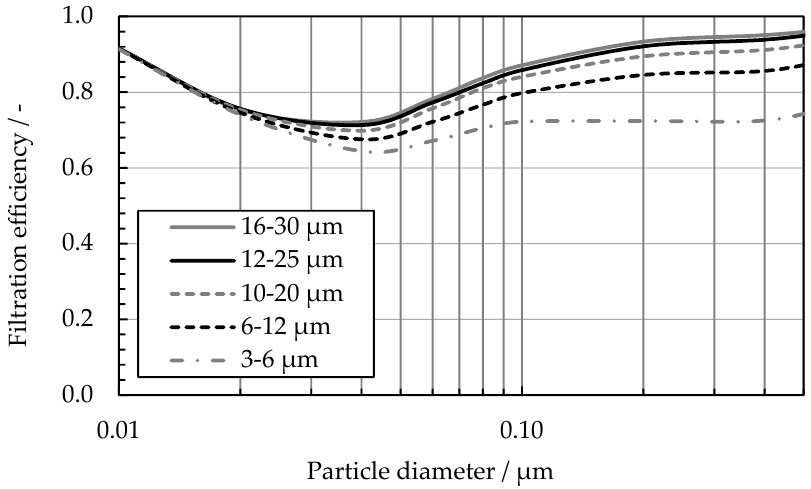
Figure 7. Filtration efficiency of a bipolar charged fibrous structure with equal area ratio of positively and negatively charged surfaces depending on the spot size for charge modeling.